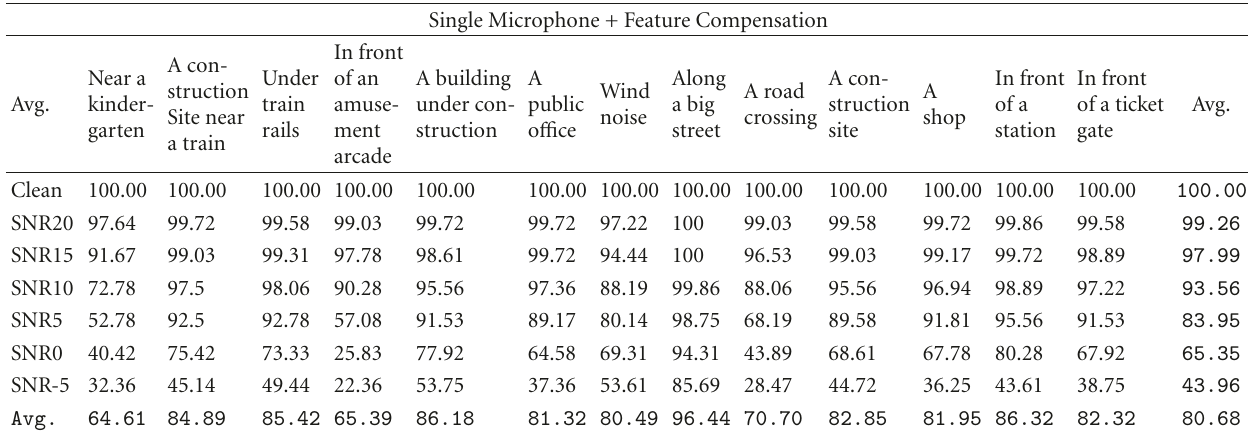
Table 2: Recognition accuracy of the single microphone followed by feature